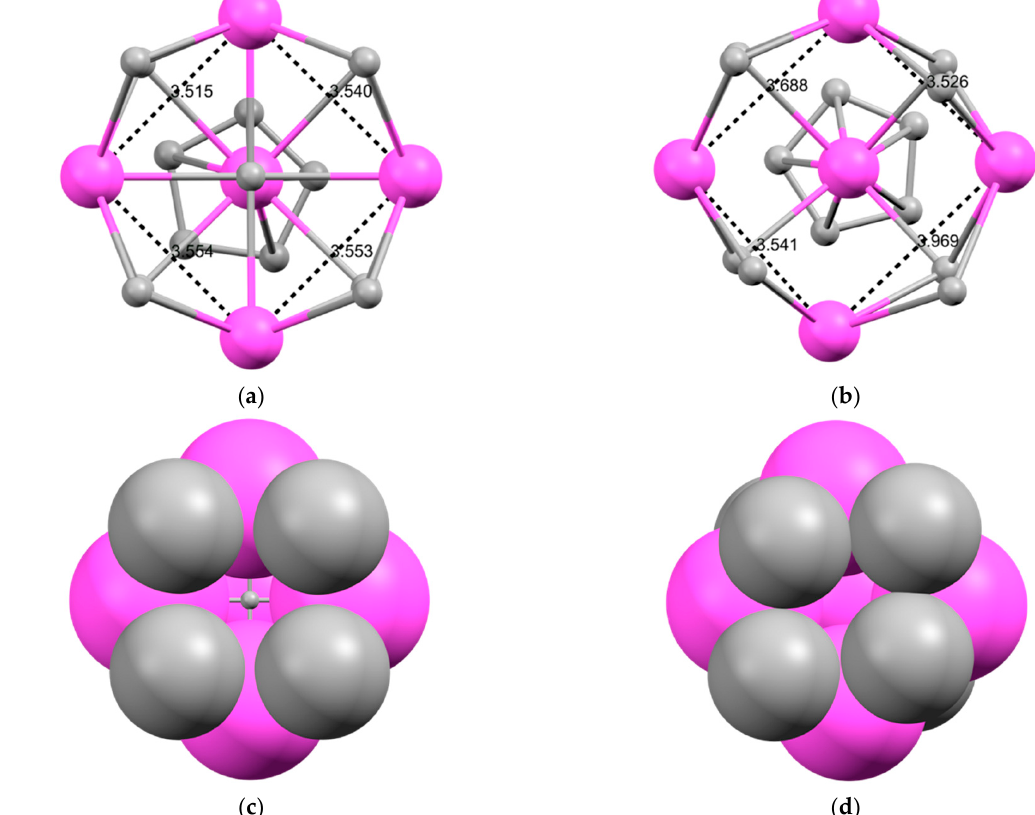
Figure 8. Comparison of the coordinative geometry in complexes 3 Gd (( a ) and ( c )) and 5 Y (( b ) and ( d )). In panels ( a ) and ( b ), distances (Å) and a geometry overview of the core structure (neglecting the Cp* anionic ligands, except for that binding to the apical Ln center) are given in a ball and stick model. Panels ( c ) and ( d ) focus on the geometry of the respective base tetragon of the pyramidal cluster in visualizing the space filling of the respective atoms. Their square and rhomboid shape can clearly be observed. In panel ( c ), the centering carbon atom of the methylene dianion is visible.